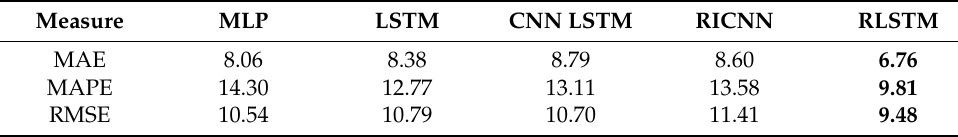
Table 5. Next-day forecast results when underestimated at peak times.